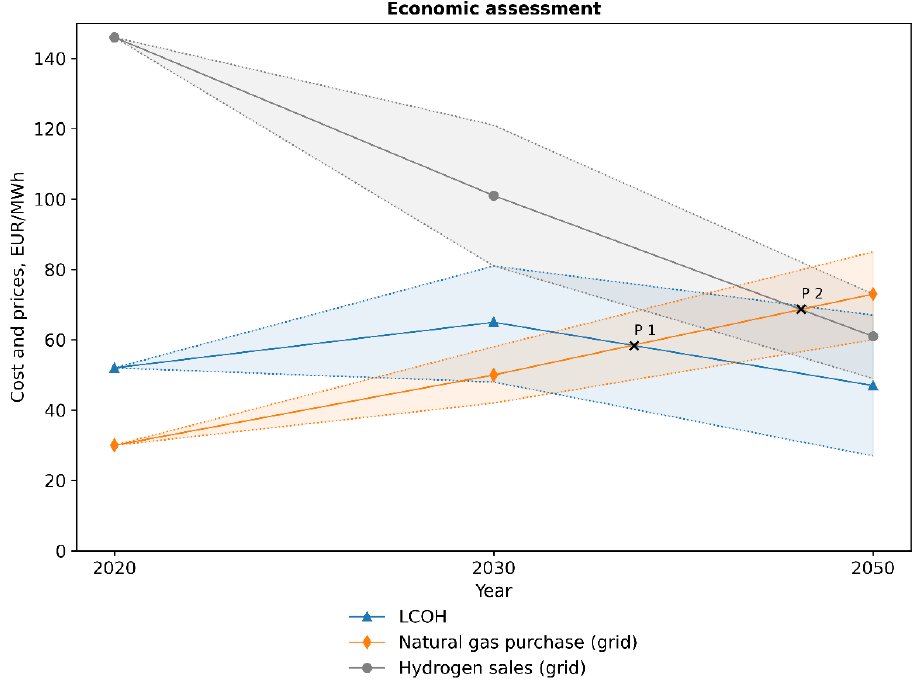
Figure 10. Comparison of the levelized cost of hydrogen and SNG with natural gas and hydrogen prices.